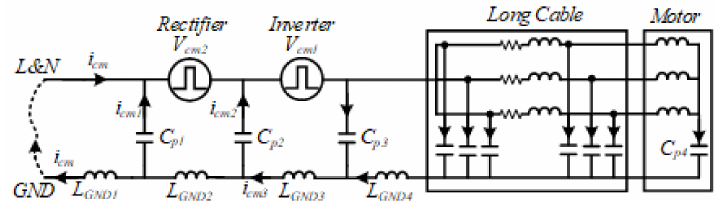
Figure 17. Equivalent CM path of the drive